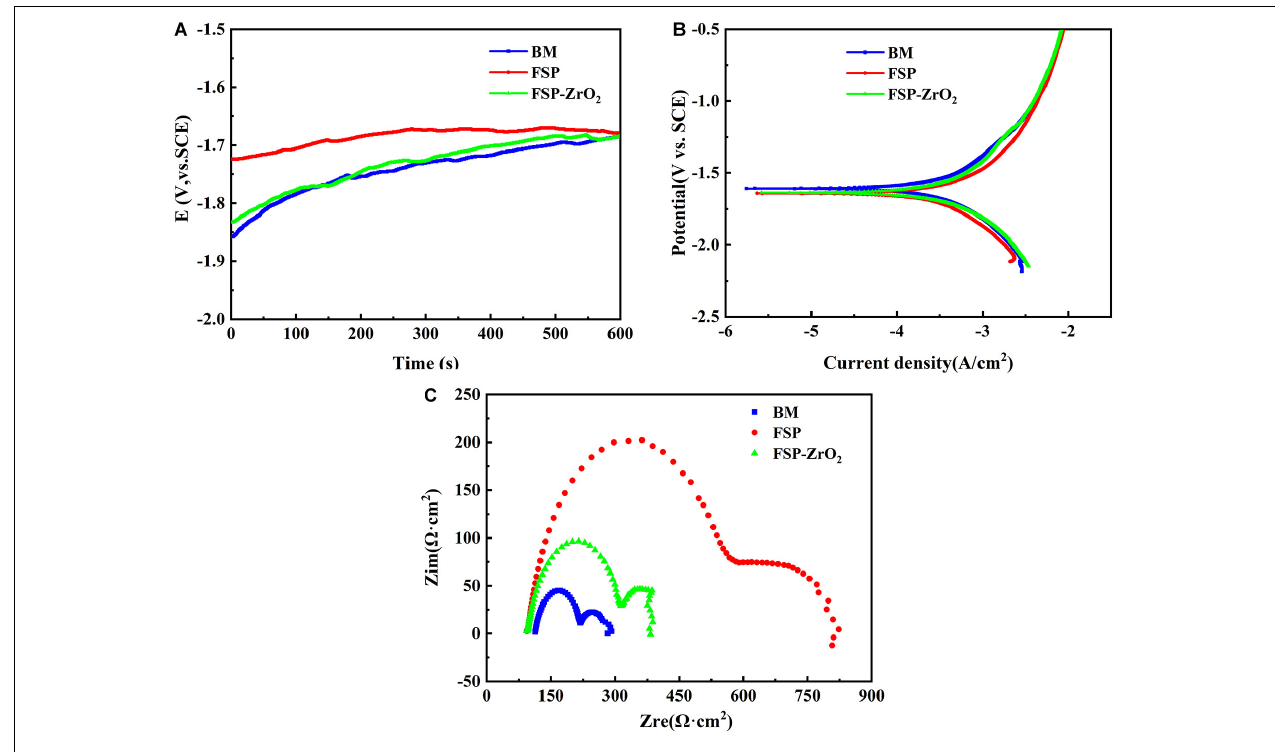
FIGURE 11 | The BM, FSP and FSP-ZrO 2 samples in SBF solution: (A) E versus time curves; (B) Tafel polarization curves; (C) Nyquist plots.